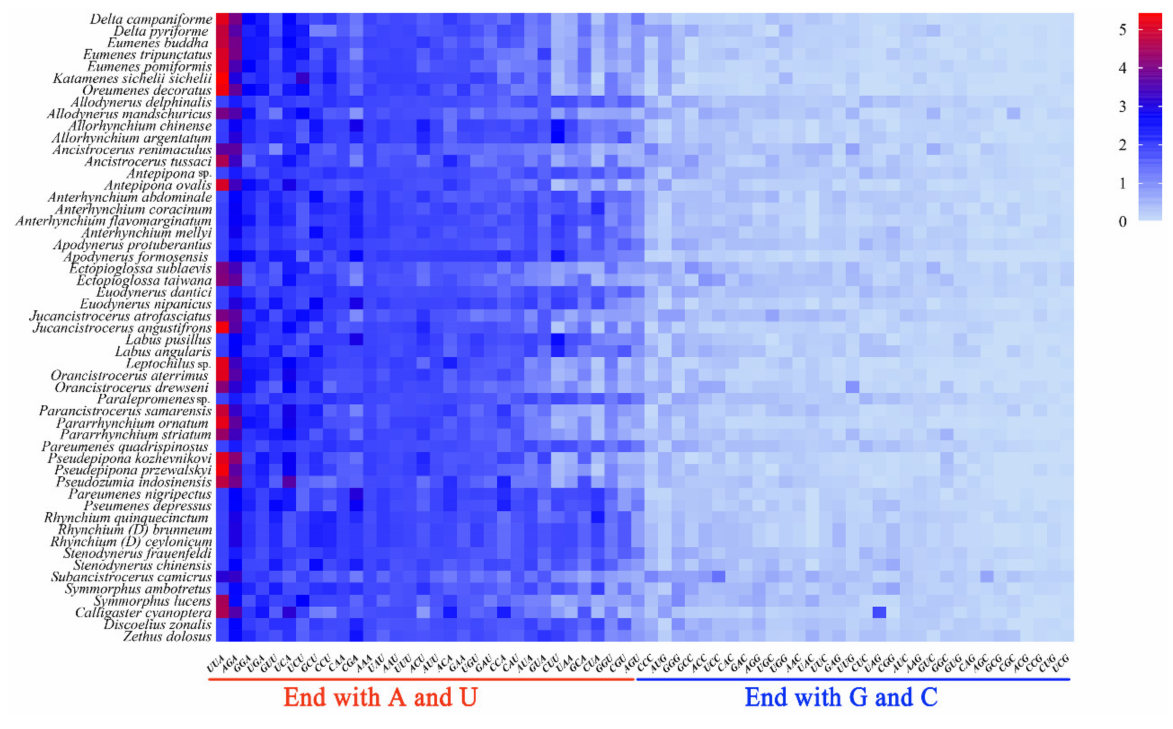
Figure 4. Relative synonymous codon usage (RSCU) of the mitogenomes of Eumeninae. The synonymous codon usage bias is influenced by mutation pressure and natural selection, and an effective number of codons (ENC) standard curve can indicate that the determinant of codon preference is mutation pressure or natural selection [58]. Our result shows that all the points lie under the standard curve, which indicates that the codon usage bias is influenced by selection pressure (Figure S3). Ka/Ks is the ratio of the number of nonsynonymous substitutions per nonsynonymous site ( K a) to the number of synonymous substitutions per synonymous site ( K s), which could indicate something about the selective forces acting on the protein [59]. Thus, we computed the Ka/Ks value of PCGs from eumenine mitogenomes, and the result shows that all the Ka/Ks of PCGs except ND4L are less than 1, which indicates that only ND4L is under a positive selection and evolves rapidly, and other PCGs are under a purifying selection. Moreover, the lowest Ka/Ks value of COX1 (0.11) indicates that it is conservative under environmental selection pressure and suitable for molecular barcoding (Figure 5).